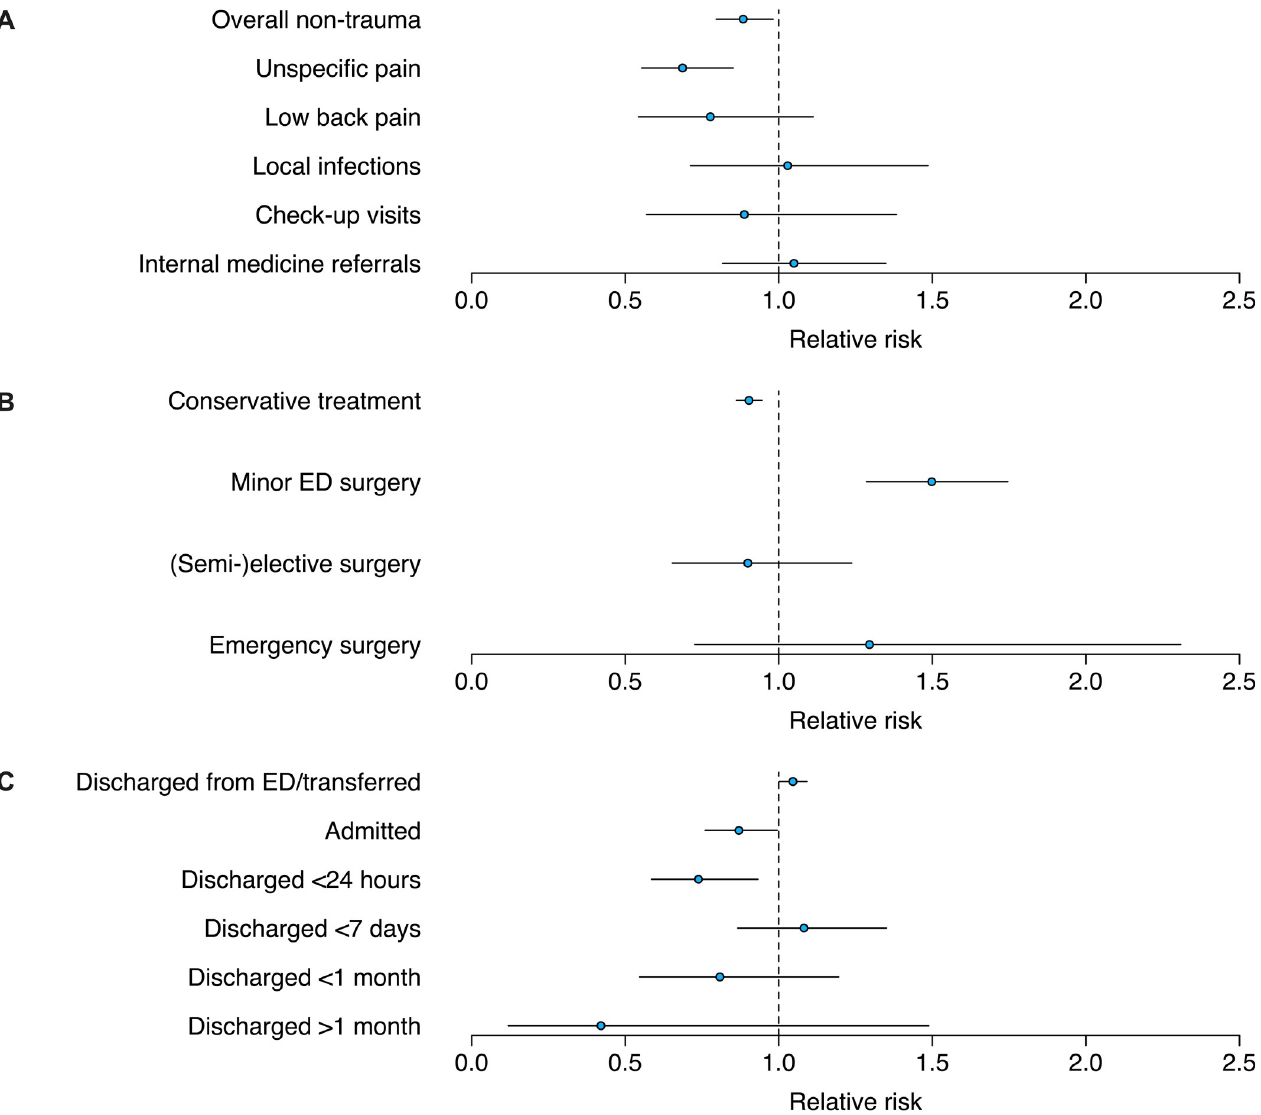
Fig 4. Plots showing RRs during the SHUTDOWN compared to the CTRL period for selected outcomes. (A) Non-traumatic orthopedic visits, (B) treatment and (C) discharge metrics. Circles indicate RRs (SHUTDOWN vs. CTRL) and whiskers the 95% CIs. ED = emergency department.